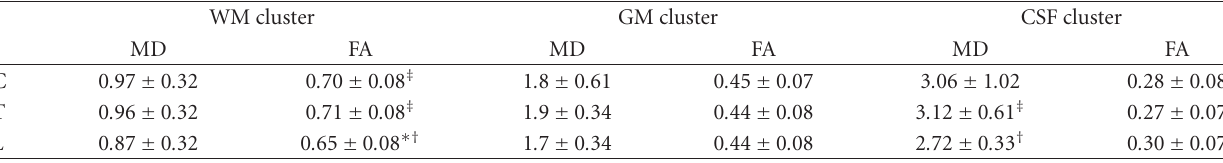
Table 1: MD and FA values for each tissue type along each region of the cord.